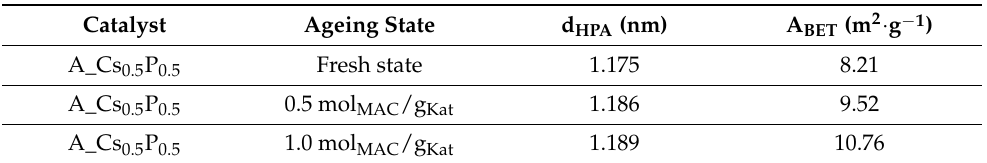
Figure 11. Catalytic performance of A_Cs 0.5 P 0.5 at 300 ◦ C and 21% v/v water. MAC conversion over modified residence time ( left ) and MAA selectivity over conversion ( right ). Data shown for three cumulated amounts of converted MAC at an elevated temperature of 340 ◦ C. Table 4. Unit cell parameters and specific surface area of A_Cs 0.5 P 0.5 for three cumulated amounts of converted MAC at an elevated temperature of 340 ◦